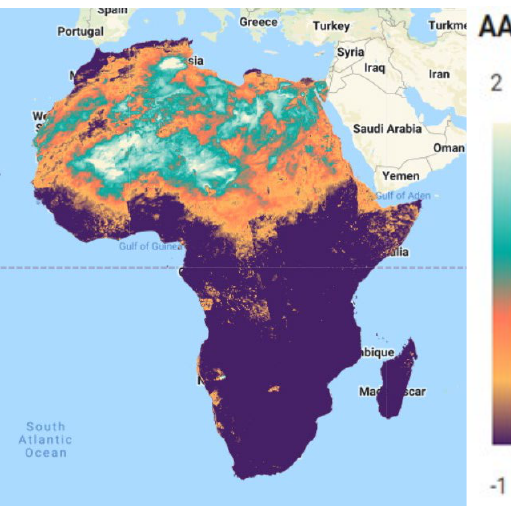
Fig. 4. Aerosol movement from 4th – 6th June of 2020 Furthermore, the dust plume extended to eastern countries such as Sudan and Northwards toward Libya as shown in Fig. 5.